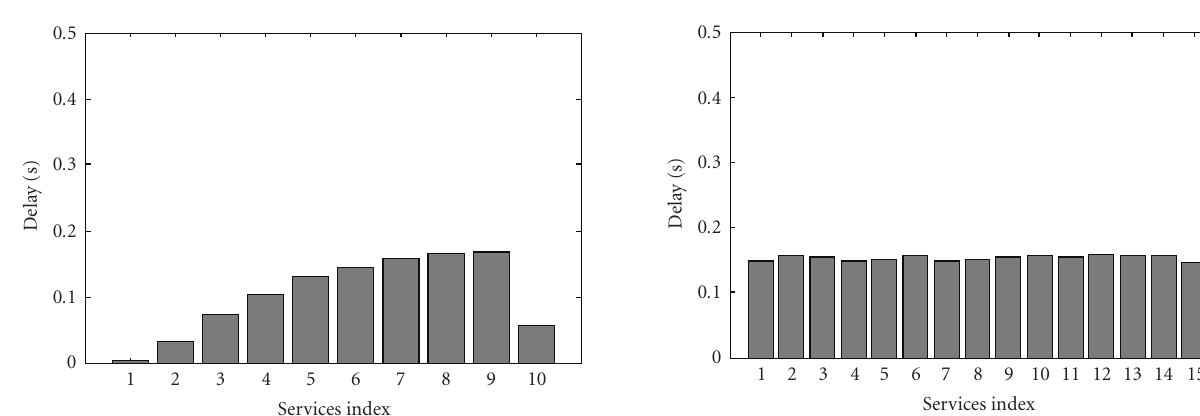
Figure 8: Bu ff ering delay in StatMux for the bit streams used in Figure 7.